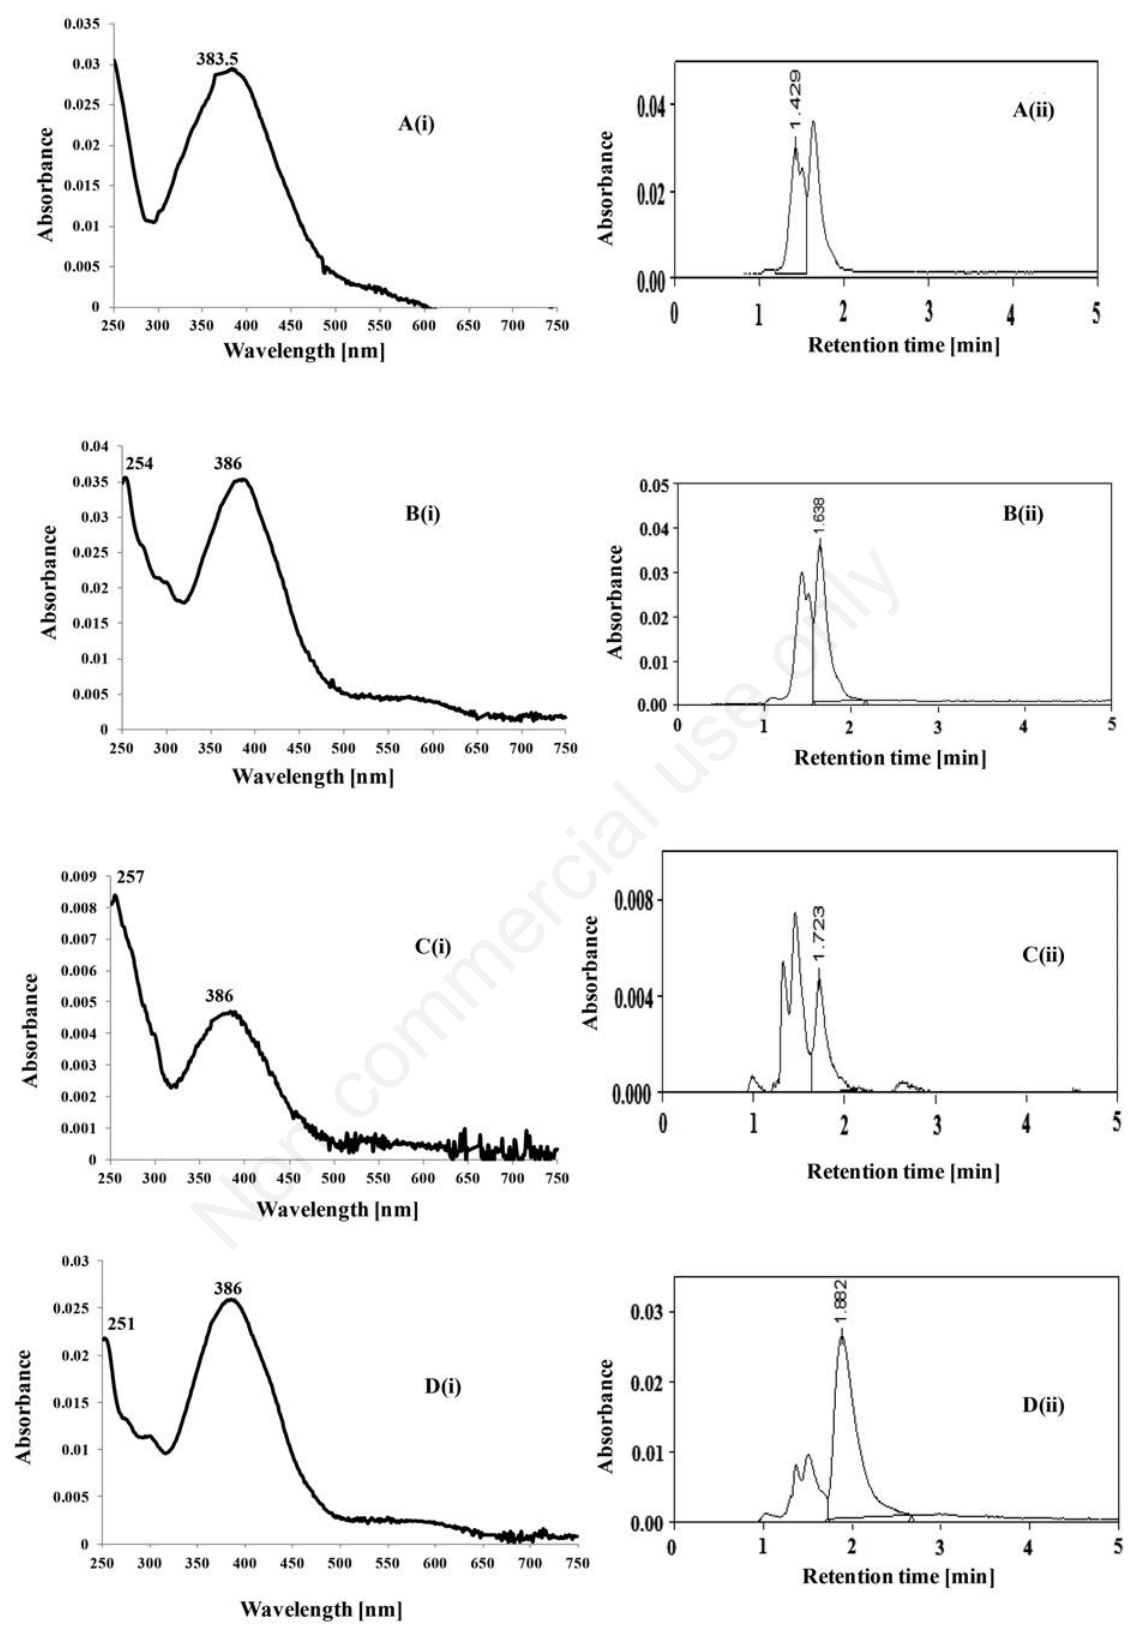
Figure 8. Absorption spectra of partially purified scytonemin (i) and its corresponding HPLC chromatograms (ii) from crust samples of (A) Madhavrav’s Dharhara, (B) Brahaspati Temple (RT 1.63), (C) Brahaspati Temple (RT 1.73) and (D) Jalnigam’s old tank. All the experiments were repeated thrice with at least three